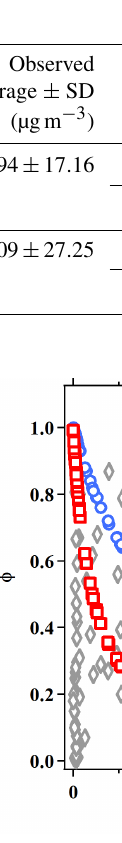
Figure 5. Relationship between the ClNO 2 yield, (cid:56) ClNO molarity ratio of H 2 O to Cl − . Gray diamond symbols, blue circles, and red squares represent the observed (cid:56) ClNO parameterization, and those fitted from the empirical parameters de- rived in the present study,